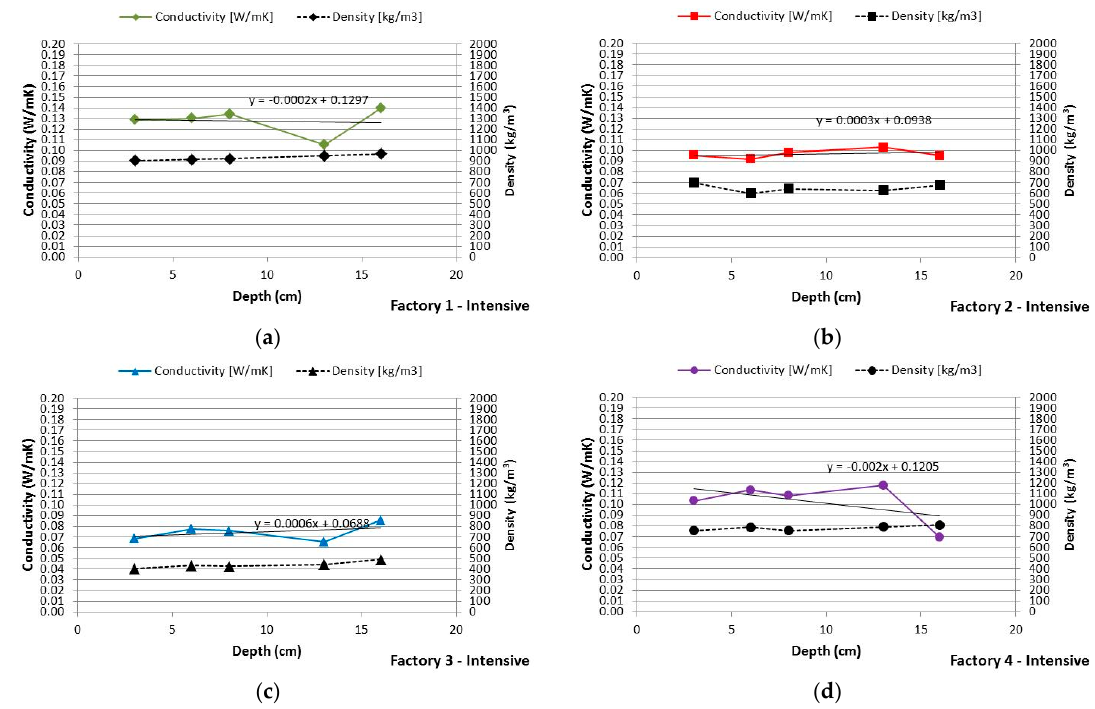
Figure 5. Dry thermal conductivity—intensive samples; ( a ) Factory 1, ( b ) Factory 2, ( c ) Factory 3, ( d ) Factory 4.